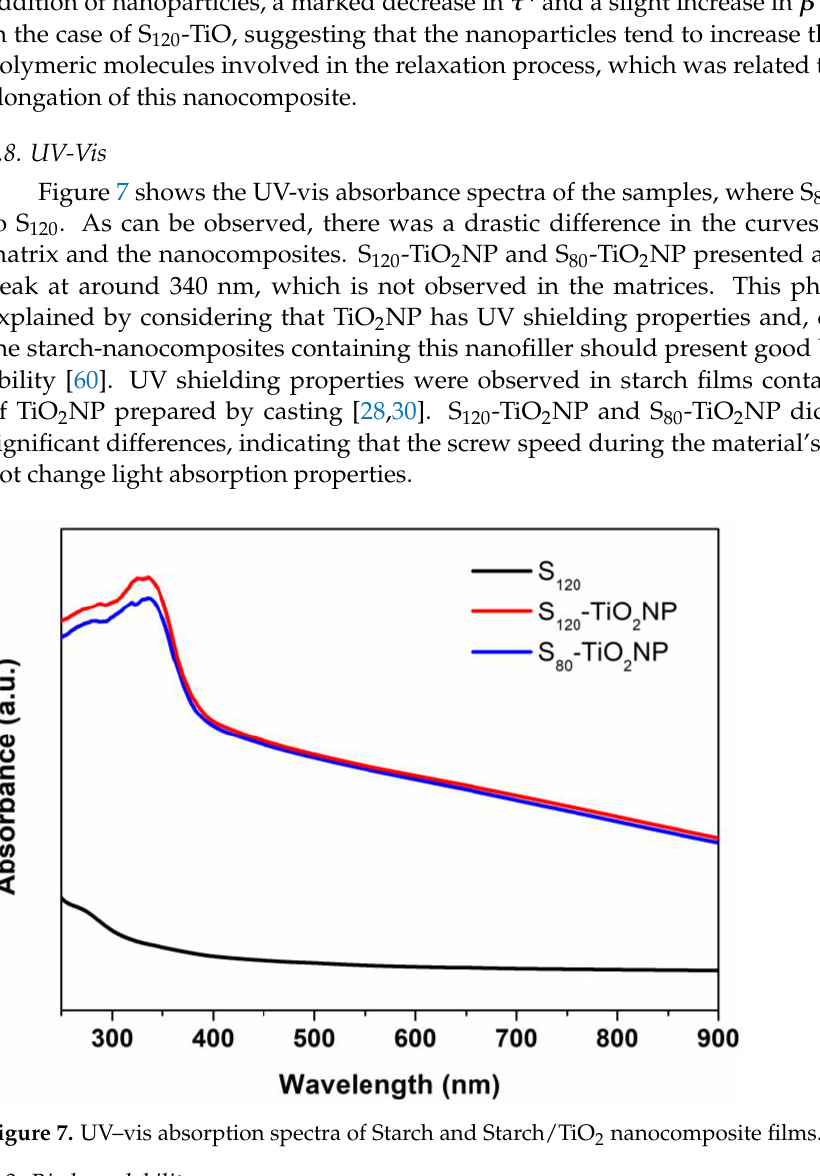
Figure 8. Percentage mineralization as a function of time for S 120 , S 120 -TiO 2 NP and starch in the DMR system. Mineralization error bars for the replicates are represented at selective times to facil- itate the reading of the plots. During the first 10 days, the mineralization rate of starch (reference) was higher than that of S 120 , and afterward, both materials ’ biodegradation rates were similar almost all of the time. S 120 mineralization’s curve is similar , as shown in the literature in starch-based films prepared by extrusion, and its initial slower biodegradation could be a consequence of the lower surface area of the films compared to starch powder [61,62]. Briassoulis et al.